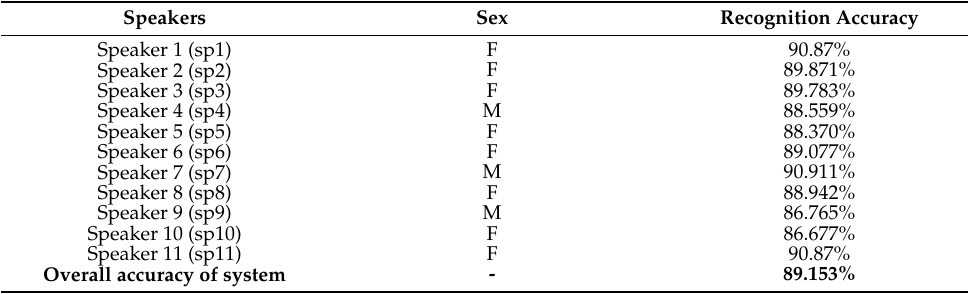
Table 6. Recognition rates of different speakers in current ASR system.